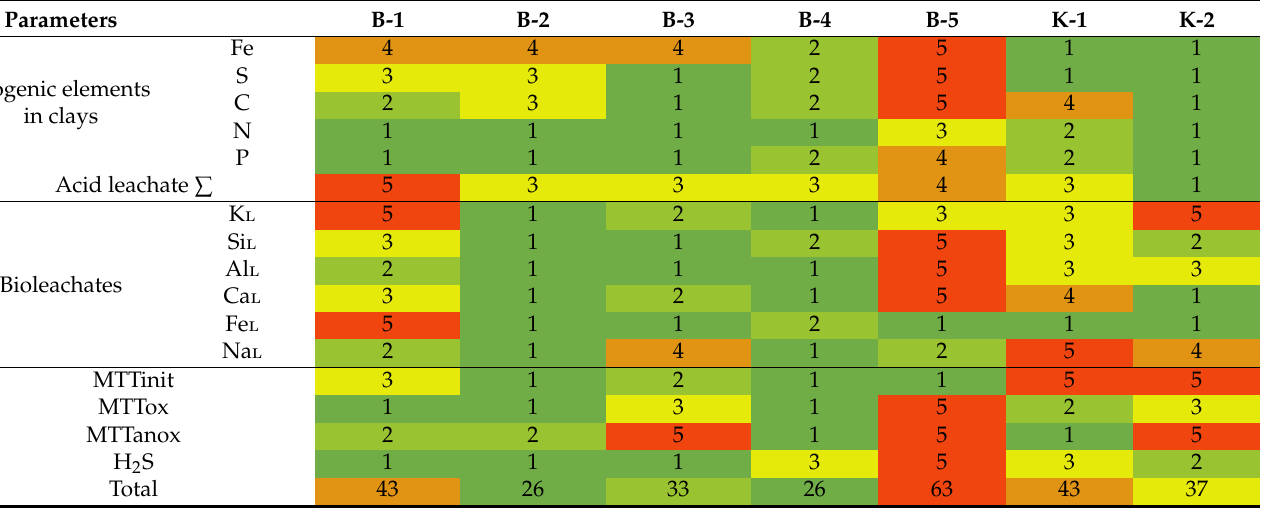
Table 9. Overall safety prediction for clay